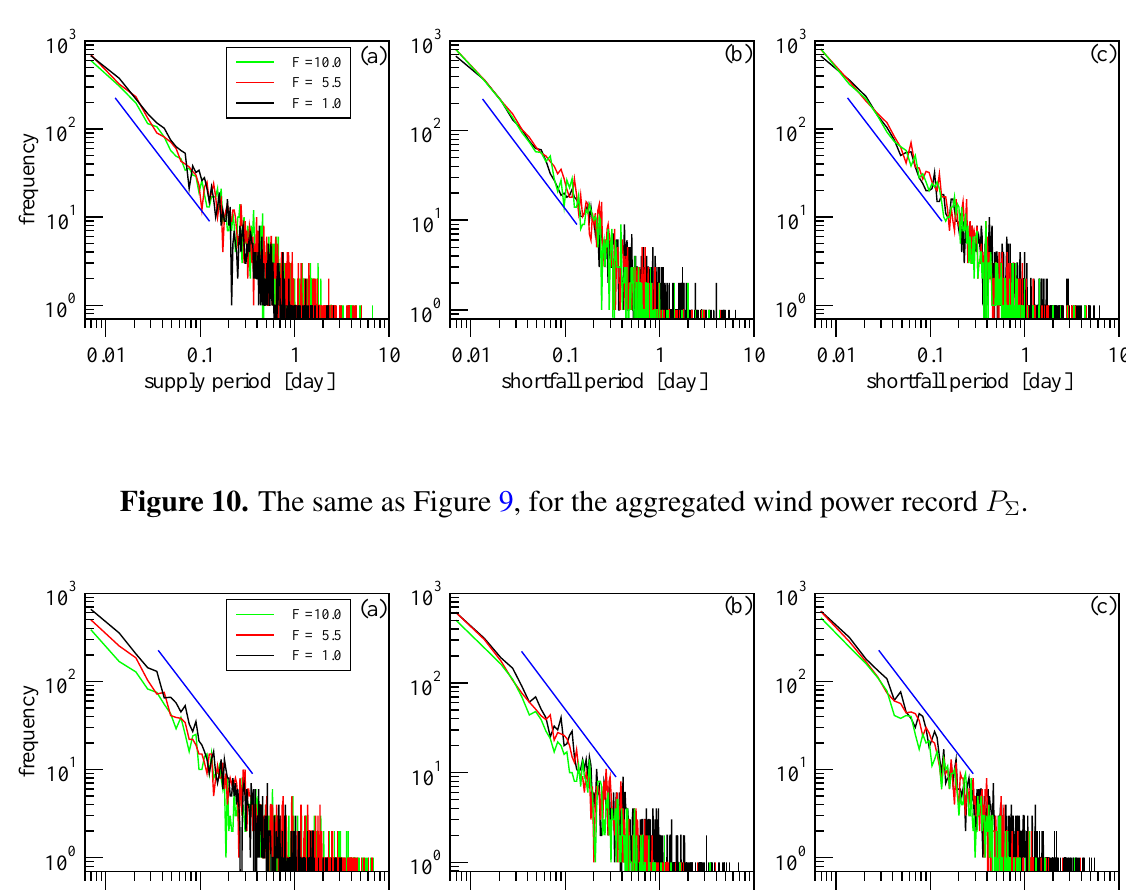
Figure 9. Length distribution of continuous periods of (a) supply, (b) shortfall, and (c) shortfall with constant consumption at three values of F (see legends) for wind power record P . (Note the double logarithmic scale.) Blue lines indicate a power-law with exponent K value − 1 . 4 .